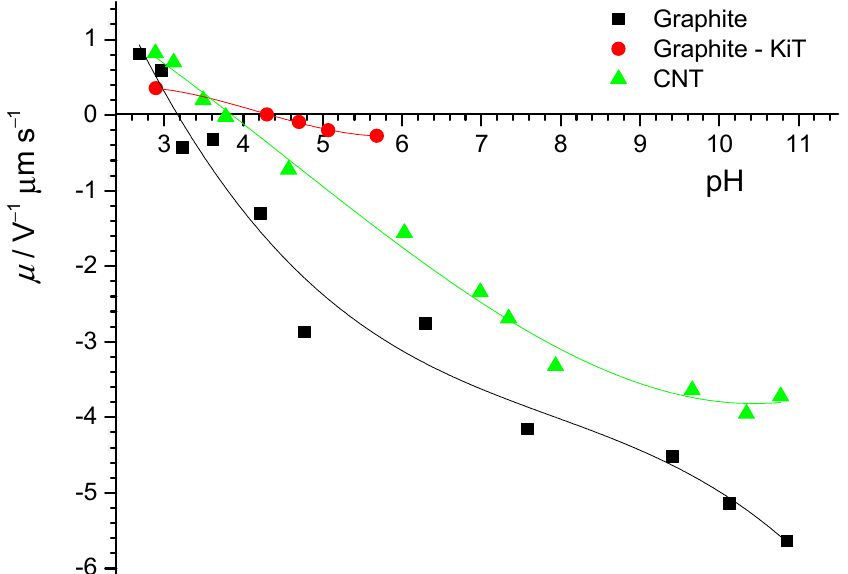
Figure 6. Electrophoretic mobilities of graphite (Zg), graphite—KIT (H-PGC), and CNT in aqueous sodium chloride solution at 25 °C. Lines represent third order polynomial fit used to determine pH iep . I c = 2 mmol dm − 3 for graphite and CNT, I c = 1 mmol dm − 3 for graphite—KIT.